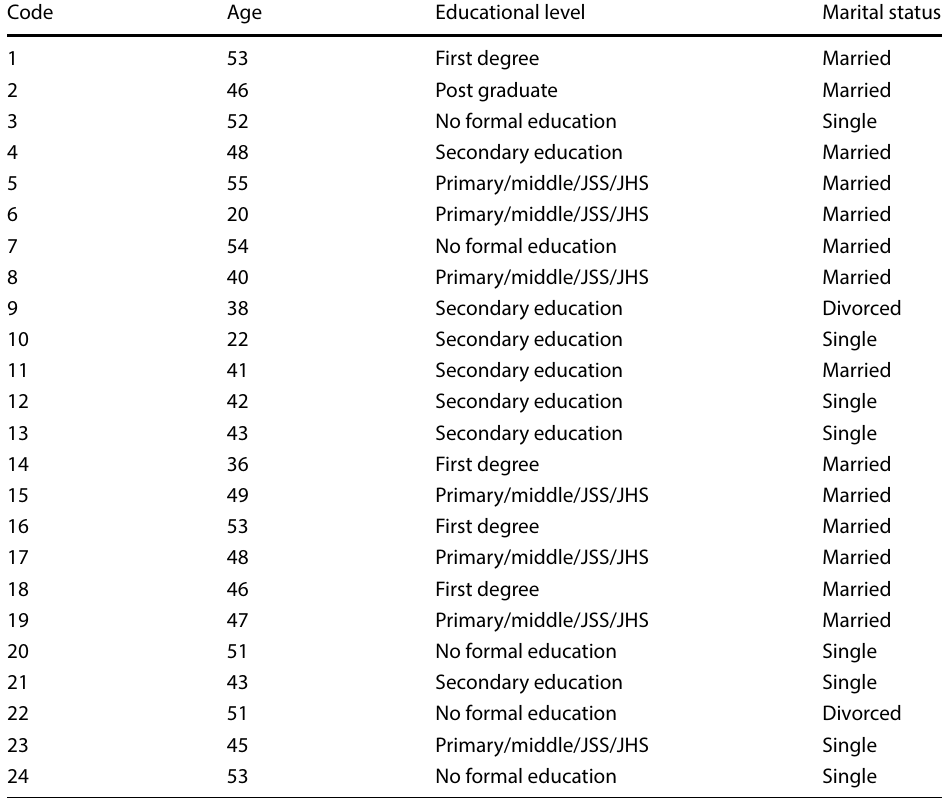
Table 2 Demographic characteristics of participants in the Focus group